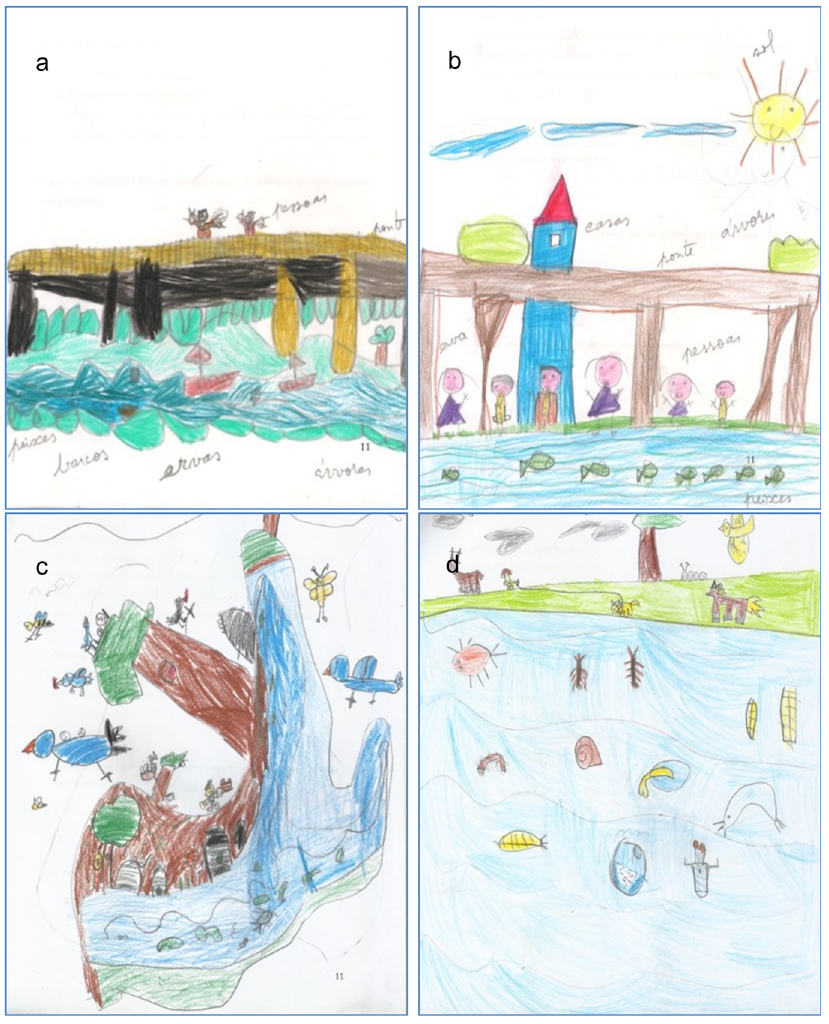
Fig 4. Examples of drawings made by children in the M2 –after the first field trip (a, b) and M3 –after the second field trip and laboratory class (c, d).